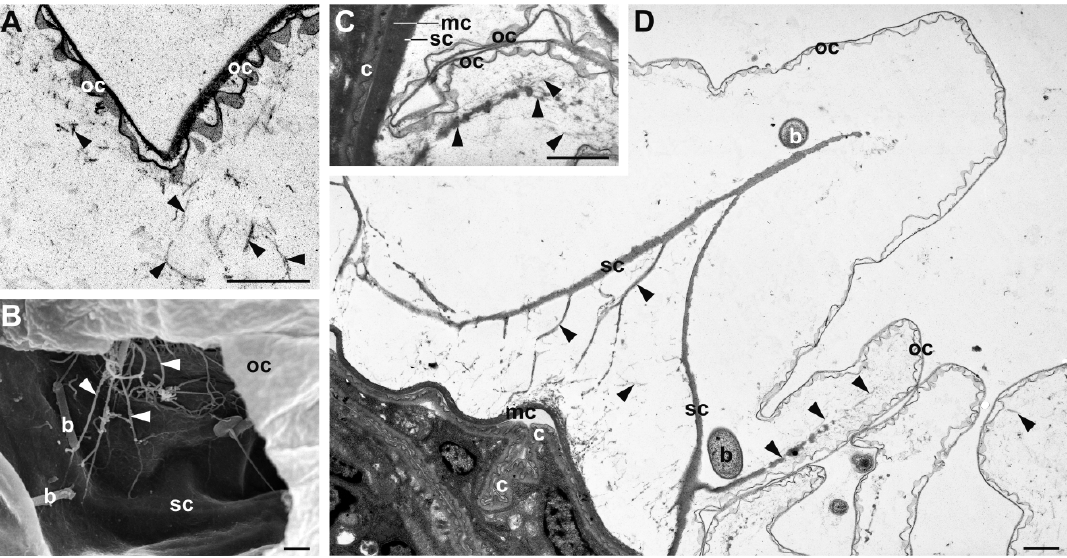
Figure 5. Cyst and its cuticles. Cuticular capsule of the cyst, TEM ( A , C , D ), and SEM ( B ). Scale bars 1 μ m. Bacteria (b); cuticle of the animal (c); mummy cuticle (mc); old cuticle (oc); sarcophagus cuticle (sc); cuticular connections (filled arrowhead).